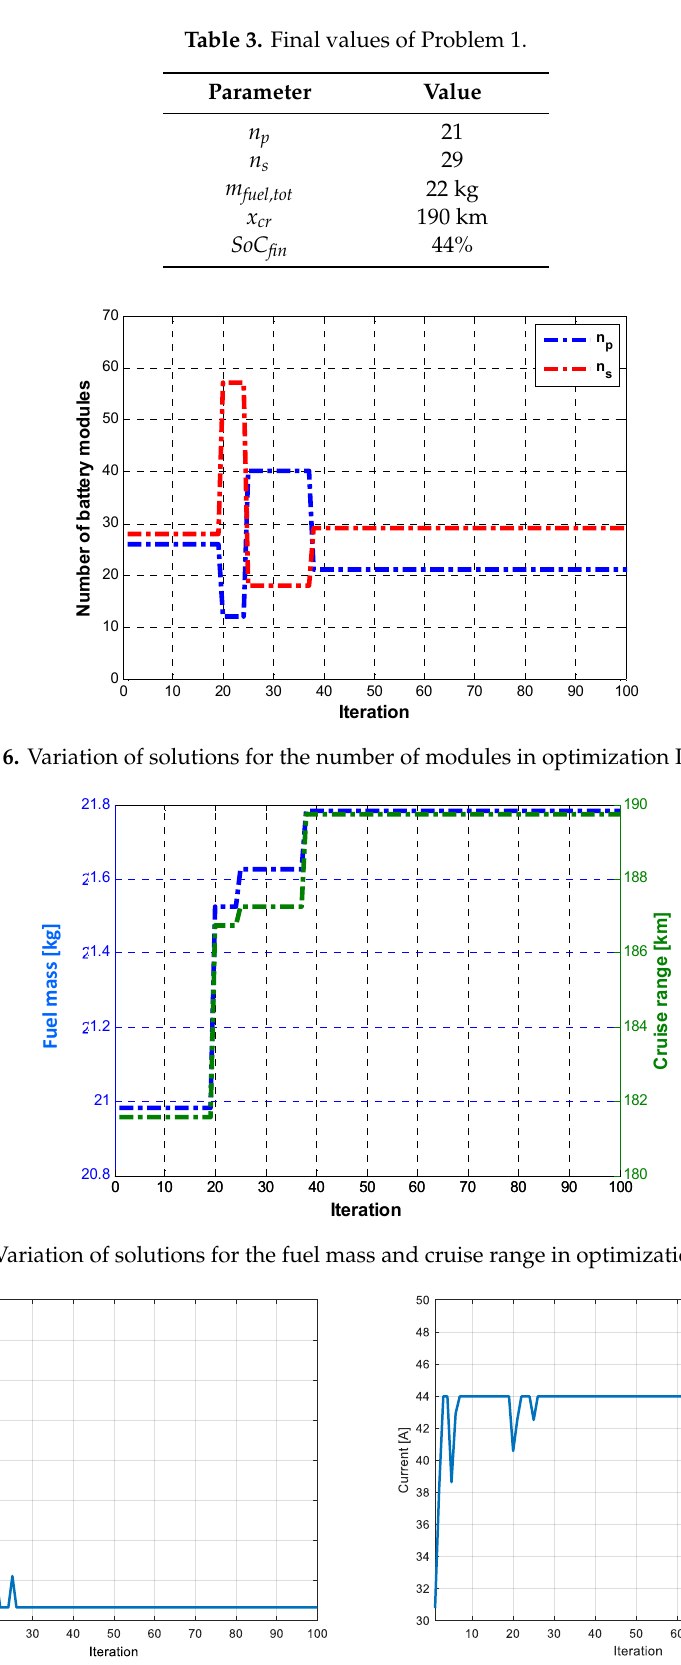
Figure 8. Variation of state of charge ( SoC ) of the battery pack and the current in the climb phase in optimization Problem 1. Table 4. Problem 1 for different cells and the DC-link voltage.